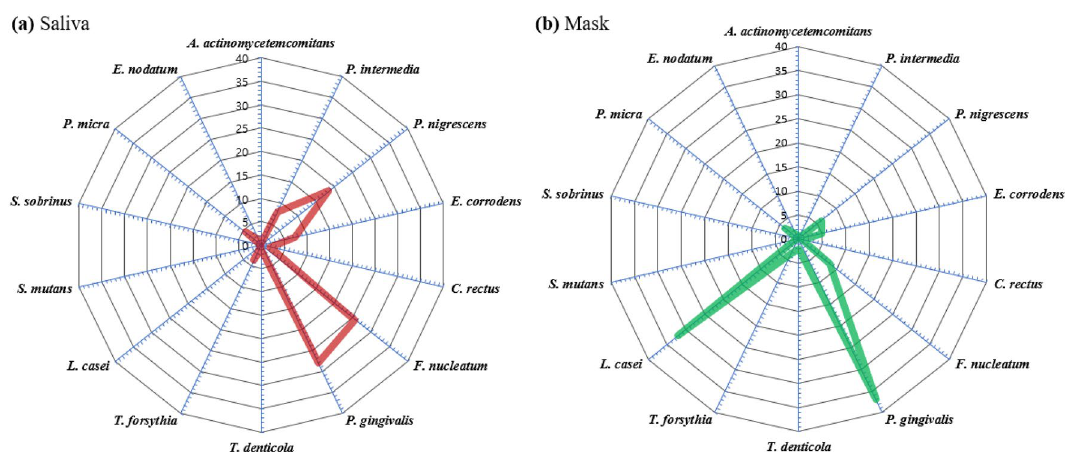
Figure 3. Bacterial profile in ( a ) saliva and ( b ) mask samples. Saliva: DNA copy number of each bacterium detected in saliva, mask; DNA copy number of each bacterium detected on the inner surface of the